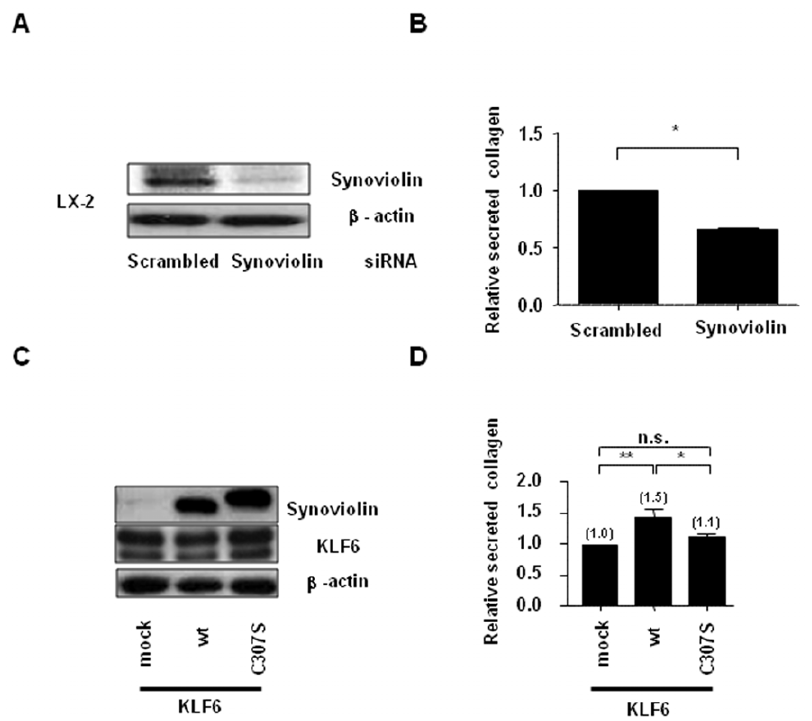
Figure 4. Regulation of secreted collagen expression in culture cells by synoviolin ligase. (A) Immunoblotting analysis of whole-cell lysates of scrambled siRNA- and synoviolin siRNA-treated LX-2 cells by using anti-synoviolin antibody. The results were derived from 3 independent experiments. (B) The amount of soluble secreted collagen in culture supernatants of scrambled siRNA- and synoviolin siRNA-treated LX-2 cells as quantified by the sircol collagen assay method. The amount of collagen was expressed as a ratio by normalization to the protein concentration in each sample. Data are represented as mean 6 SD (n=3 per group). Unpaired Student’s t -test was used to evaluate statistical significance. * P , 0.01. (C) Immunoblotting analysis of whole-cell lysates of transiently transfected LX-2 cells by using anti-KLF6, HA, and b -actin antibodies. The results were derived from 3 independent experiments. (D) Effect of synoviolin on the amount of secreted soluble collagen. The control vector (mock), wt synoviolin-HA, or C307S-HA was co-transfected with the KLF6 vector (KLF6) in LX-2 cells. The amount of secreted soluble collagen in the supernatants of cultured LX-2 cells was quantified by the sircol collagen assay method. The amount of collagen was expressed as a ratio by normalization to the protein concentration in each sample. Data are represented as mean 6 SD (n=3 per group). Unpaired Student’s t -test was used to evaluate statistical significance. * P , 0.01, ** P , 0.001.